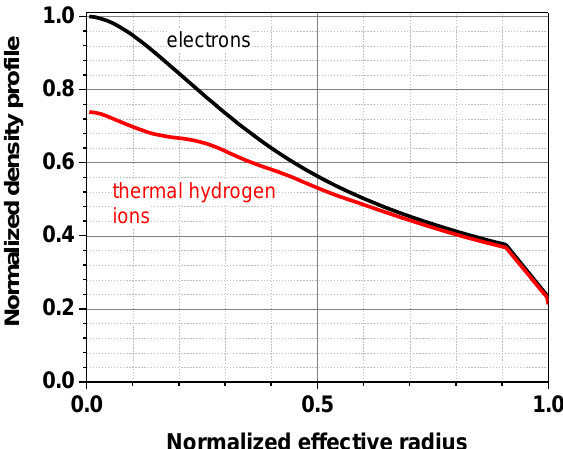
Figure 1. The electron and thermal hydrogen density profiles normalized to the central electron density for a D beam case.